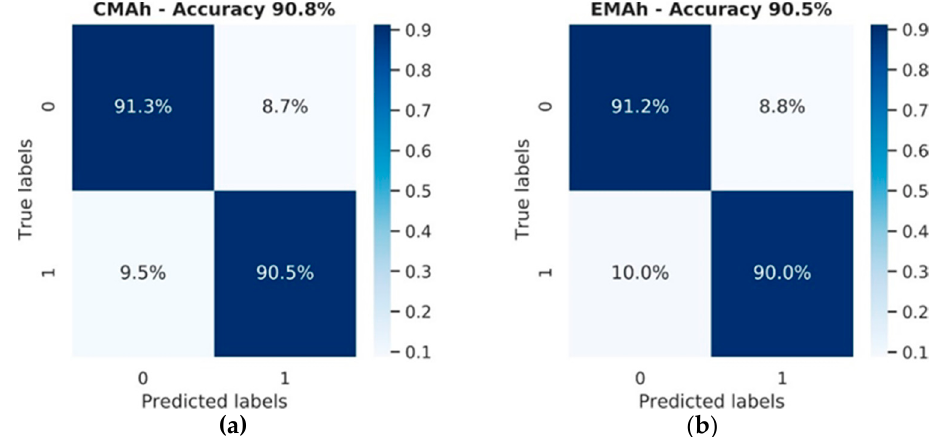
Figure 5. Confusion matrices and accuracies for the averaging approaches using the holiday heuristic. CMAh, cumulative moving average with holiday heuristic ( a ); EMAh, exponential moving average with holiday heuristic ( b ).